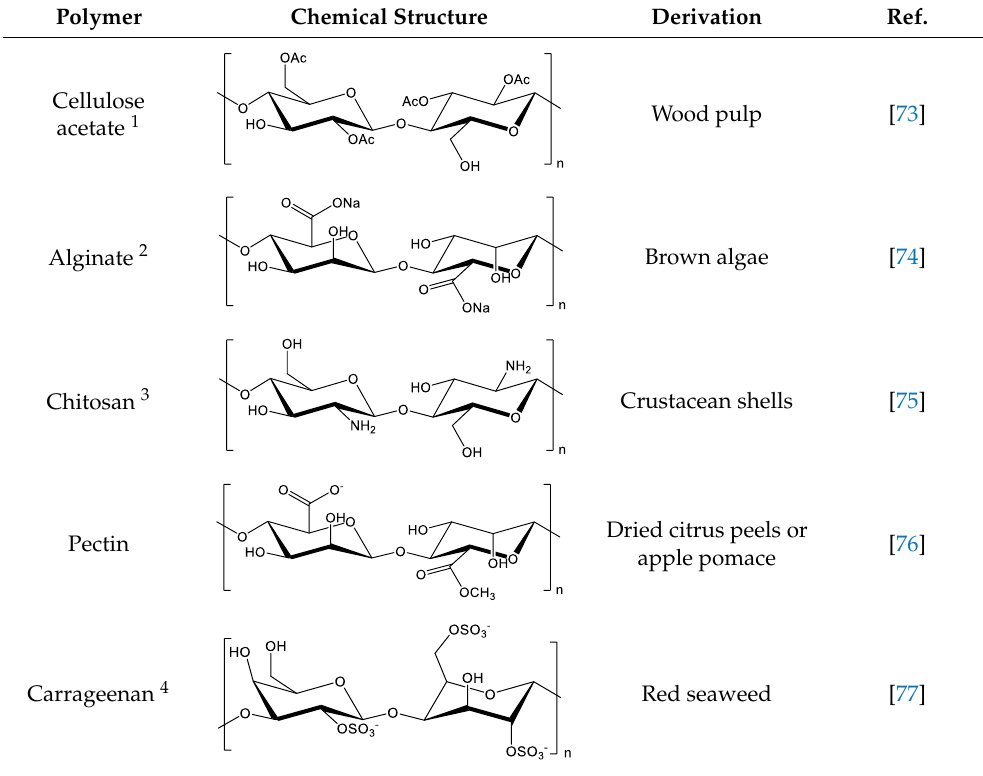
Table 2. Natural and renewable common polymers/gels employed for the development for water filtration membranes.